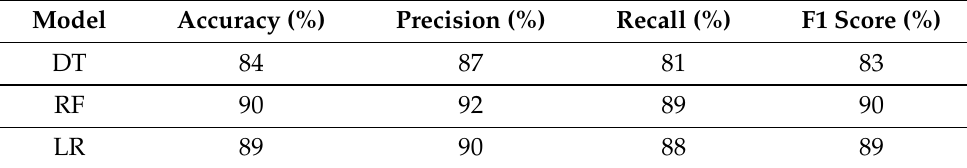
Table 16. Machine learning model performance on the AFINN